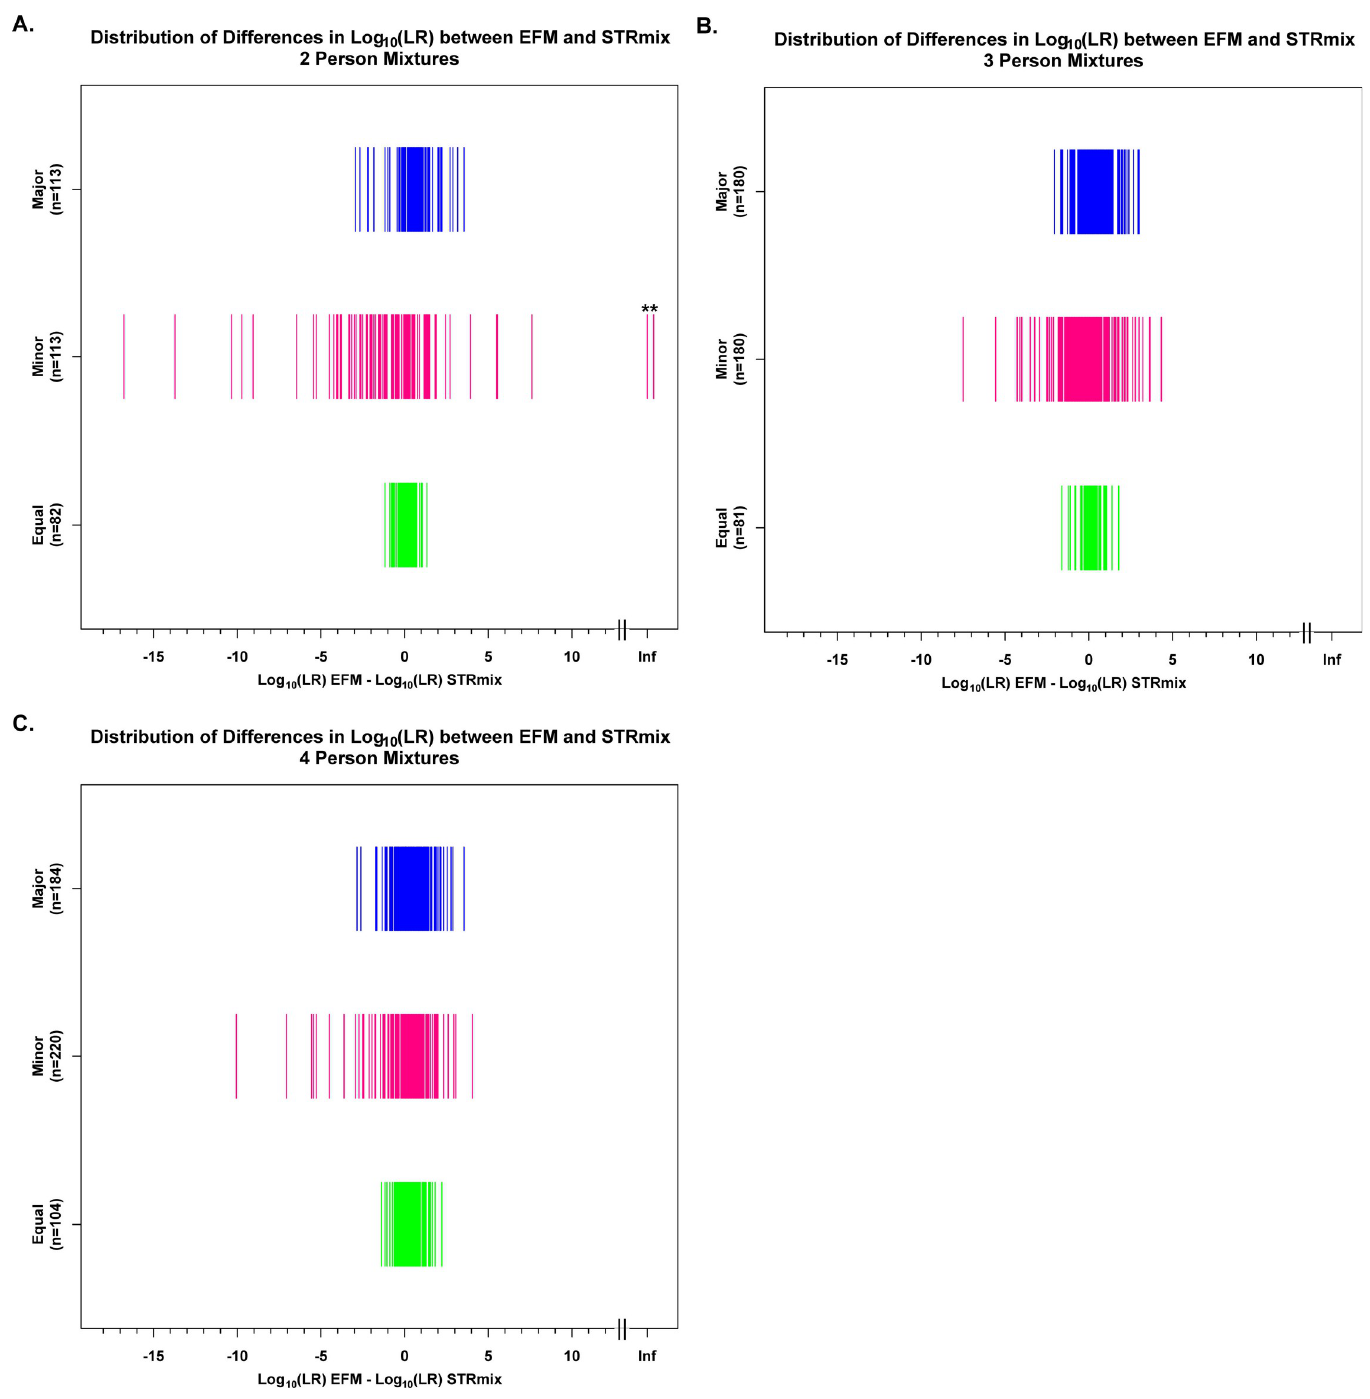
Fig 7. Distribution of differences in log 10 (LRs) across major, minor, and equal contributors. The differences in log 10 (LRs) here shown between EFM and STRmix (log 10 (LR) EFM − log 10 (LR) STRmix ) are plotted on the x-axis in log 10 scale. The y-axis shows the labels of the types of POI with their corresponding number of observations. �� are the two 2P H1-true test interpretations for which STRmix assigned profile LRs of 0 (plotted in magenta at Infinity (Inf) on the log 10 scale and discussed in detail in Section